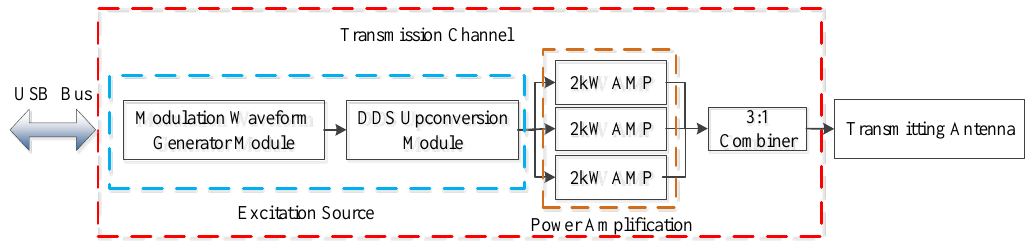
Figure 2. The transmission channel of MAI system which is mainly composed of the excitation source and power amplifier.